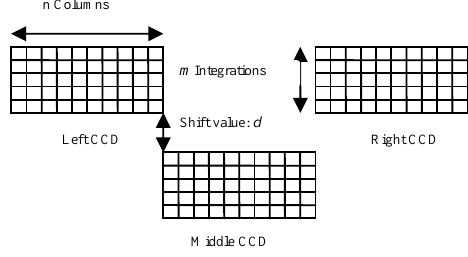
Figure 1. The designed distribution of TDI-CCD arrays on the focal plane of CBERS-02B HR